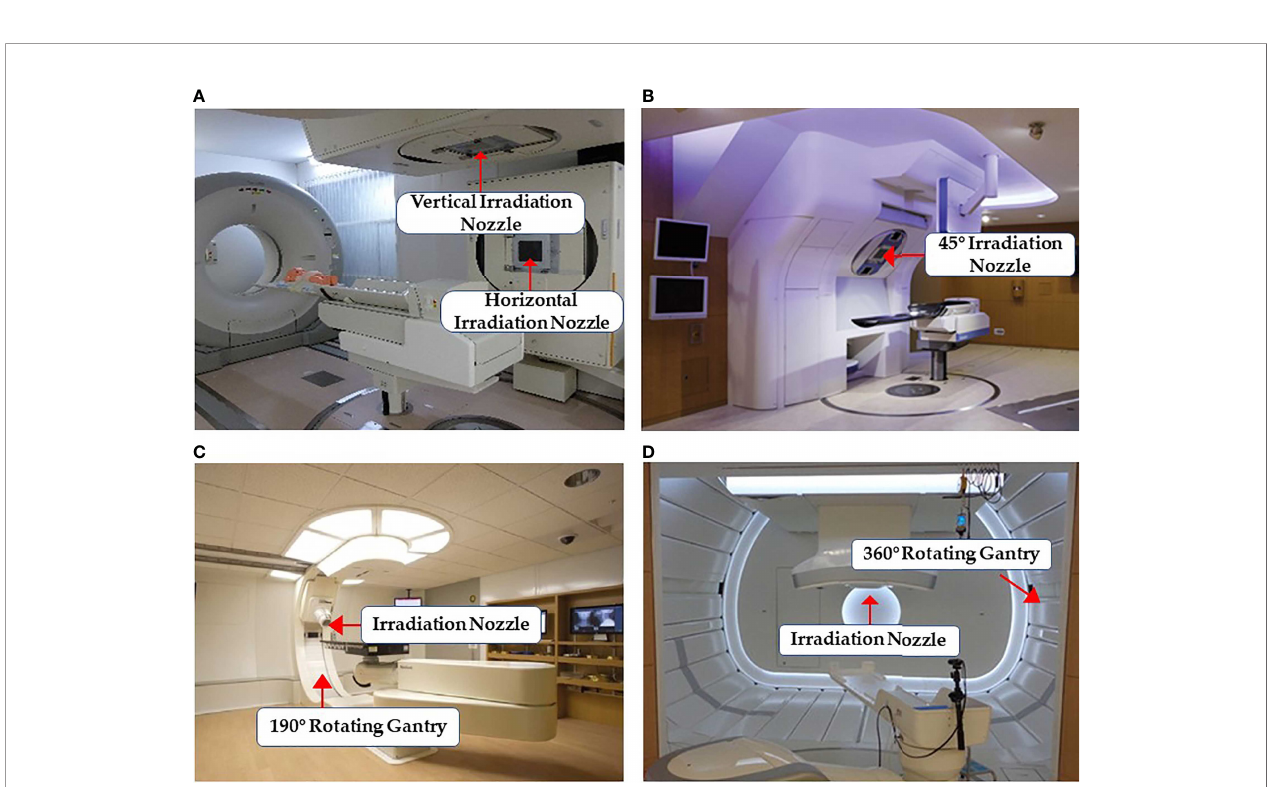
FIGURE 3 | Some common facilities of the beam delivery system in particle RT: (A) treatment rooms of carbon-ion RT with vertical and horizontal beam fi elds at Gunma University (25) (Open Assess); (B) horizontal and 45° oblique beam lines in SAGA HIMAT (26) (Open Assess); (C) a 190° rotating gantry system range − 5° to 185° for proton therapy at Barnes-Jewish Hospital (27) (Source: Missouri Medicine, Copyright 2015. Used with permission); and (D) treatment room with the superconducting rotating gantry at the National Institute of Radiological Sciences (28) (Open Assess).